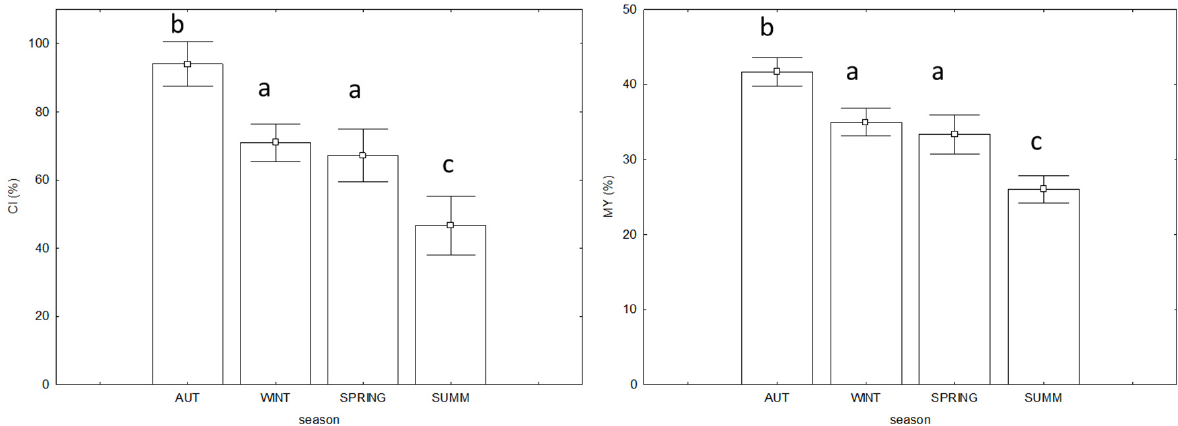
Figure 4. Condition index (CI, %) and meat yield (MY, %) of queen scallops ( n = 80) from the tanks, sampled in four seasons: Autumn (AUT), Winter (WINT), Spring (SPRING) and Summer (SUMM). The means labeled by different letters are significantly different (Tukey’s HSD test, p < 0.05).